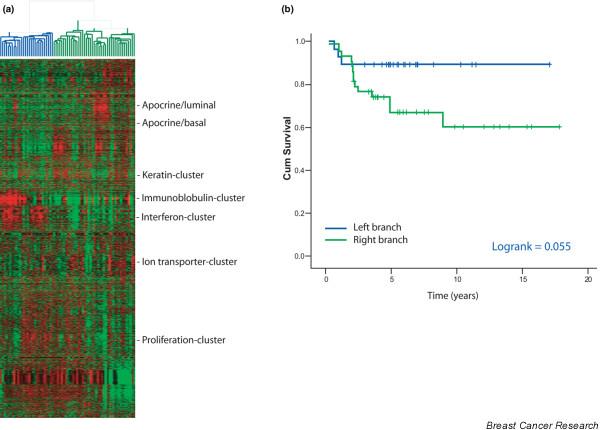
Overall gene-expression profile of triple-negative tumors associated with disease outcome. (a) Hierarchical cluster analysis of the overall gene-expression profile of 71 triple-negative tumors with identifiable gene clusters indicated on the right hand side. (b) Metastasis-free survival of 71 patients with triple-negative breast carcinomas, comparing the left branch with the right branch of the overall gene-expression hierarchical cluster analysis.